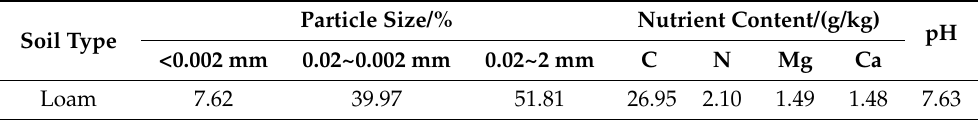
Table 1. Basic physical and chemical properties of the soil. Soil